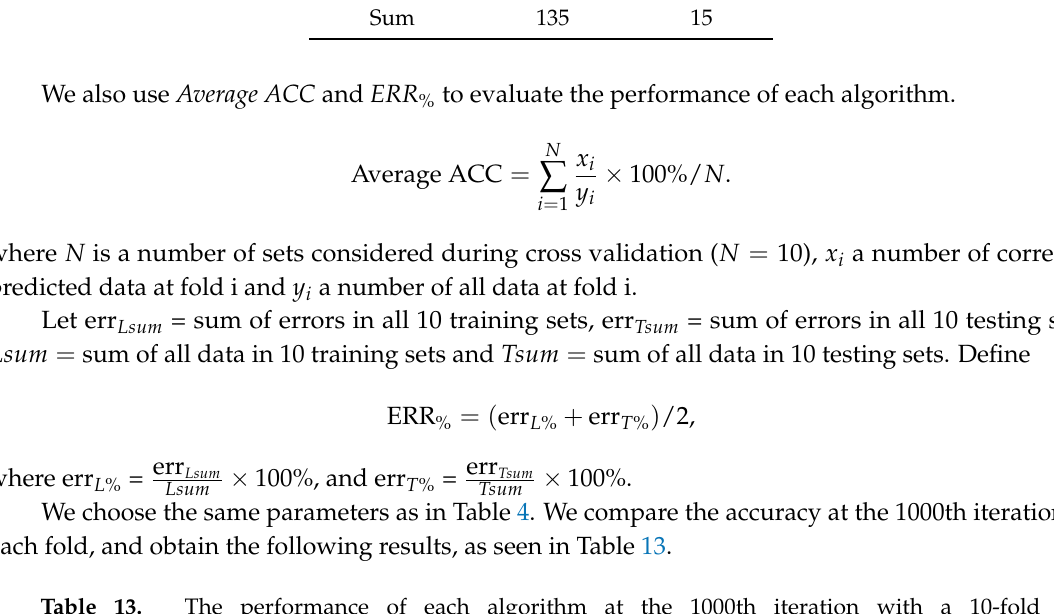
Table 13. The performance of each algorithm at the 1000th iteration with a 10-fold stratified